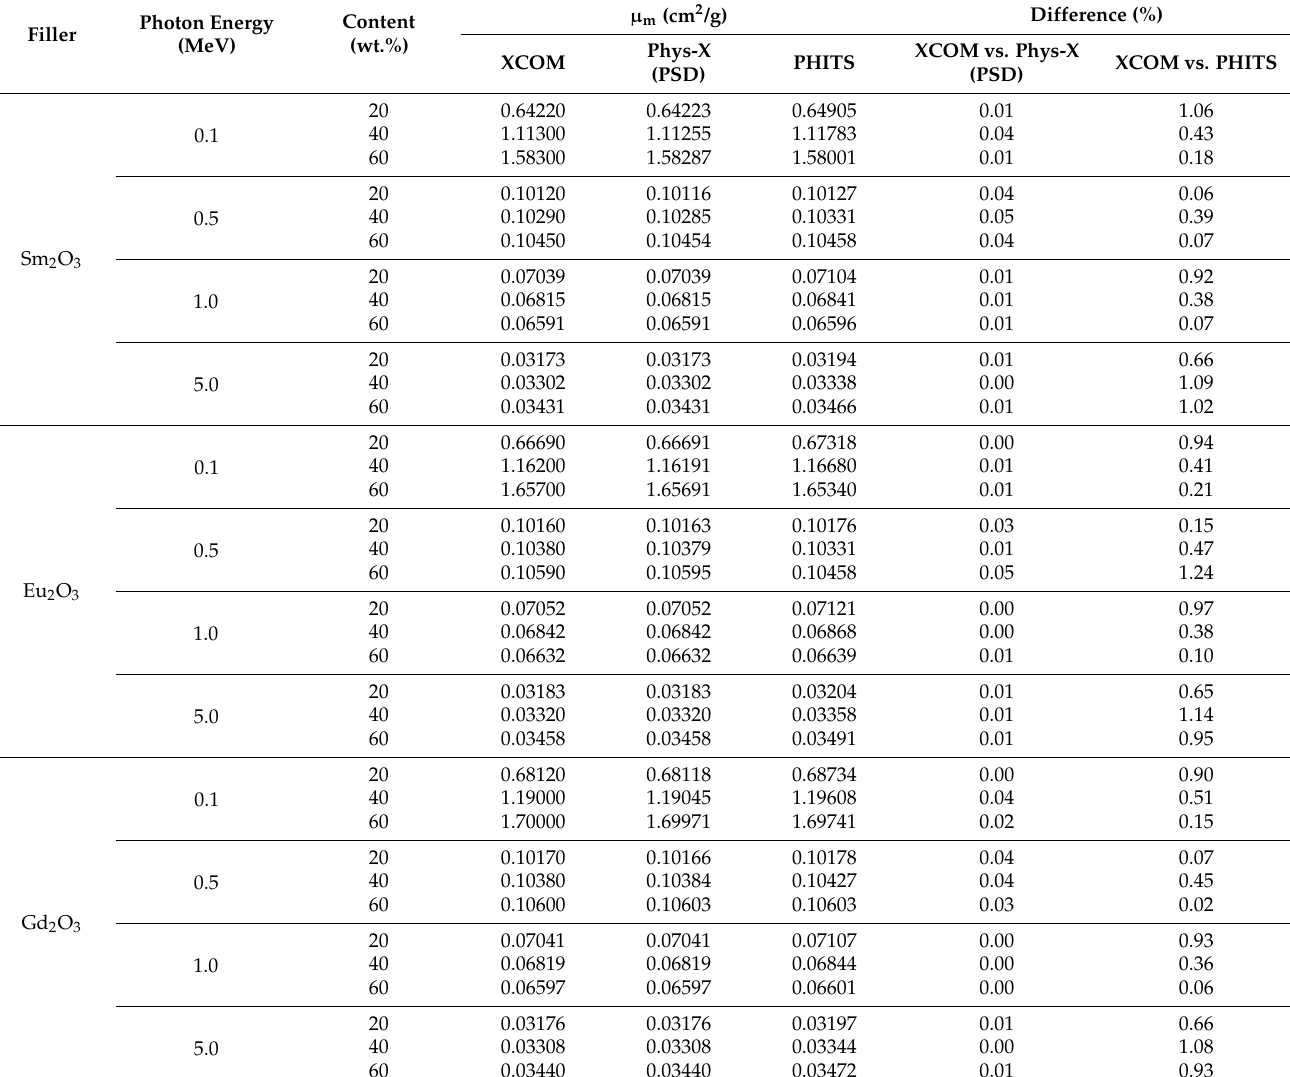
Table 3. Comparative µ m values obtained from XCOM and other programs (Phy-X/PSD and PHITS) for HDPE composites containing rare-earth oxides at various photon energies.